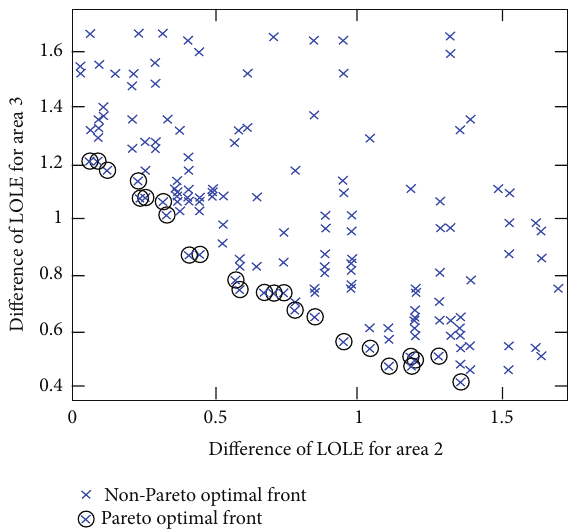
Figure 7: Pareto optimal fronts of LOLE difference for areas 2 and 3.